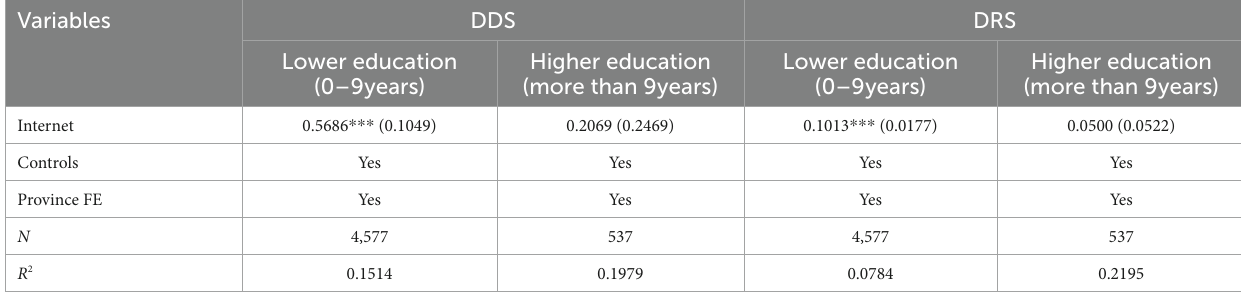
TABLE 6 Results of heterogeneity analysis on the relationship between the Internet and the educational level of household heads. Variables